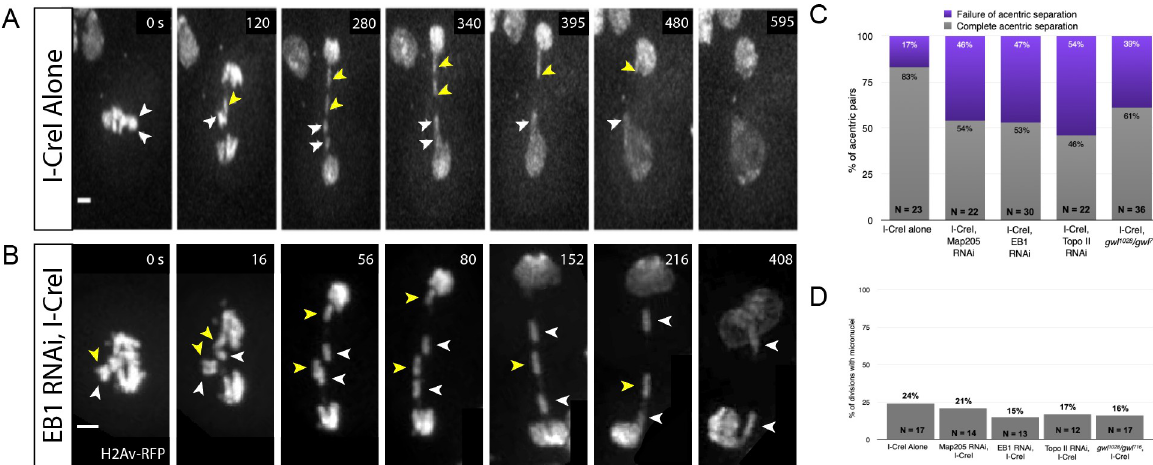
Fig 4. EB1 RNAi knockdowns specifically disrupt acentric sister separation. (A) Still frames of a time- lapse movie of a mitotic neuroblast with I-CreI induced acentrics. Paired sister acentrics (white and yellow arrowheads) lag behind at the spindle equator but eventually separate, segregate, and are reincorporated into daughter nuclei. (B) Still frames of a time-lapse movie of a mitotic neuroblast with I-CreI induced acentrics and expressing EB1 RNAi. Separation of paired sister acentrics (white and yellow arrowheads) fails, resulting in sisters segregating to and incorporating into the same daughter nucleus. Bars, 2 μ m. Time in seconds. (Video 3) (C) Percentages of neuroblast divisions in which acentric sisters failed to completely separate from one another. (D) Percentages of neuroblast divisions in which acentrics failed to incorporate into daughter nuclei and formed one or more micronuclei.